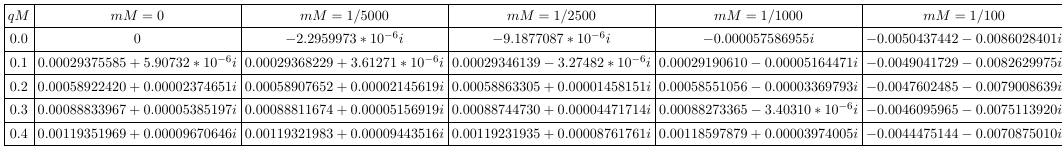
Table 7 . The QNFs ωM for massive scalar fields in the background of RNdS black holes with Λ M 2 = 10 − 4 , Q/M = 0 . 50 , ‘ = 0 , and different values of qM